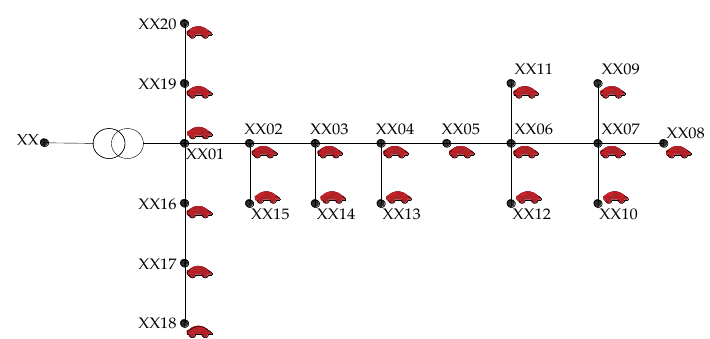
Figure 4. Topology of each LV network.